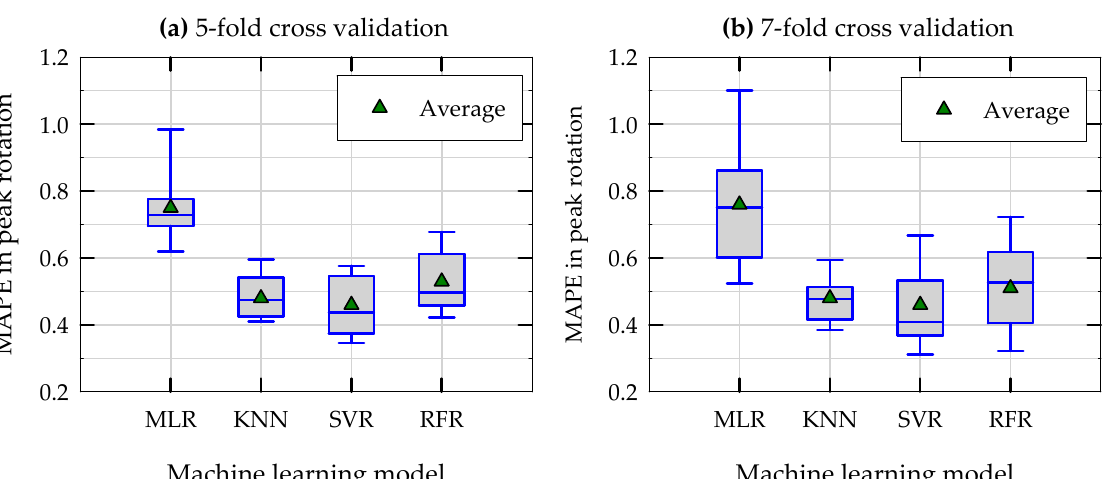
Figure 12. Boxplots of mean absolute percentage errors (MAPE) in the predictions of peak rotation of machine leaning models (k-fold testing error): ( a ) repeated 5-fold cross validation and ( b ) repeated 7-fold cross validation (Note: boxplots plot the median, 10th, 25th, 50th, 75th, and 90th percentiles of data along with the mean values (green triangles)).